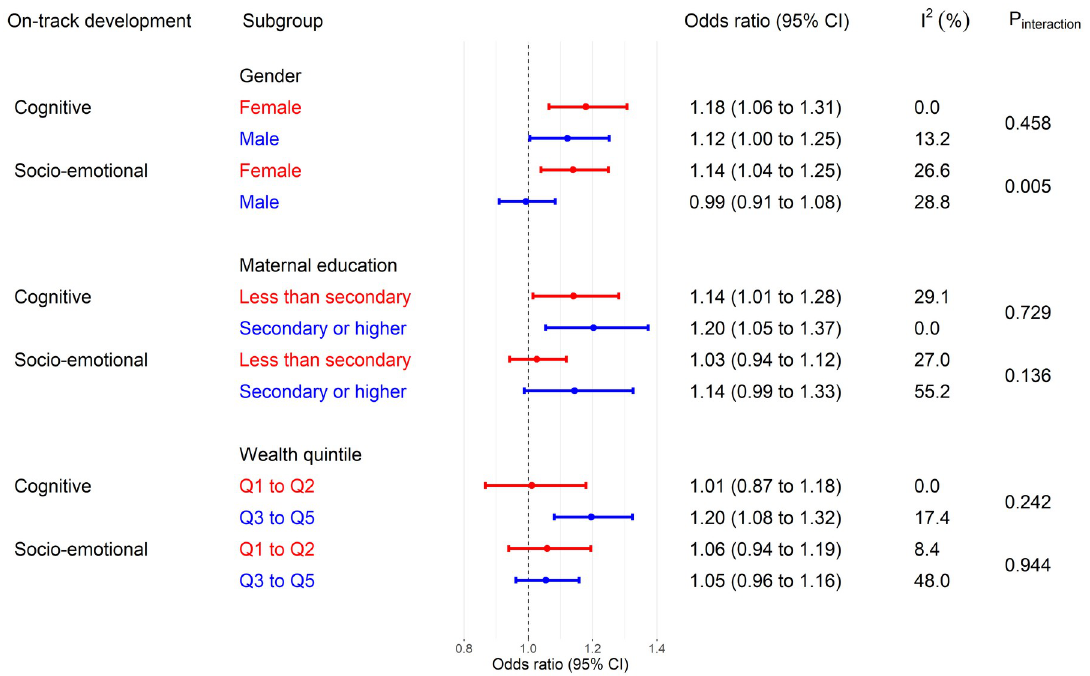
Fig 2. Subgroup analyses of the association between improved housing and ECD in children aged 36–59 months in SSA. Odds ratios are adjusted for age (months) and gender of the child, maternal education, household wealth index, and the availability of children’s books and playthings. P interaction , p -value for the odds ratio of the interaction term between improved housing and the factor (i.e., p -value for multiplicative interaction); Q1 to Q2, wealth quintile 1 to wealth quintile 2; Q3 to Q5, wealth quintile 3 to wealth quintile 5. ECD, early childhood development; SSA, sub-Saharan